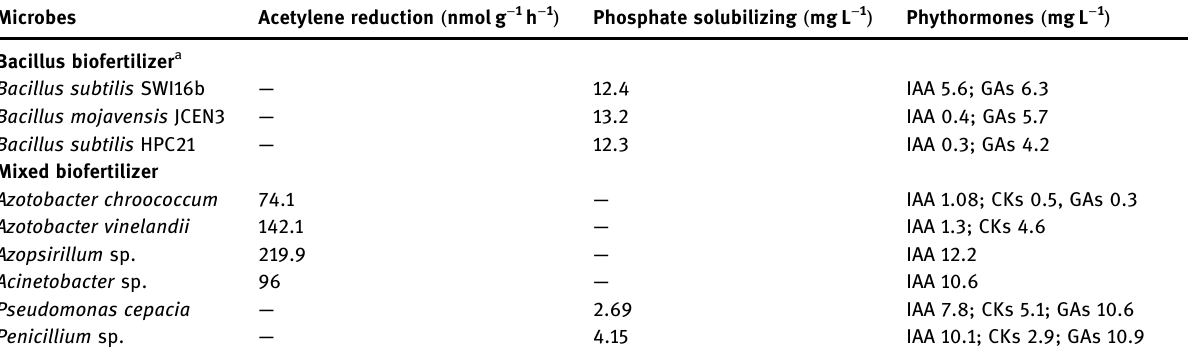
Table 1: Nitrogen - fi xing and phosphate - solubilizing capacity and phytohormone production of Bacillus and mixed biofertilizers